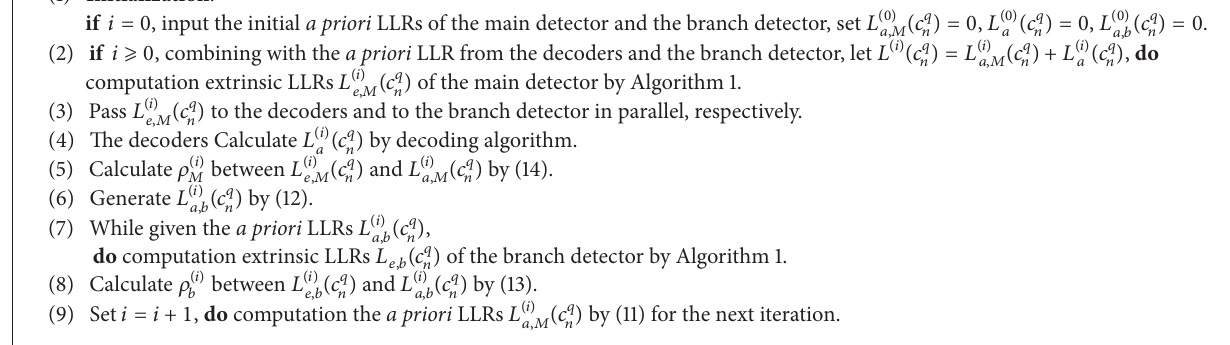
Algorithm 2: Processing procedure of the proposed Main-Branch structure turbo iteration detection.